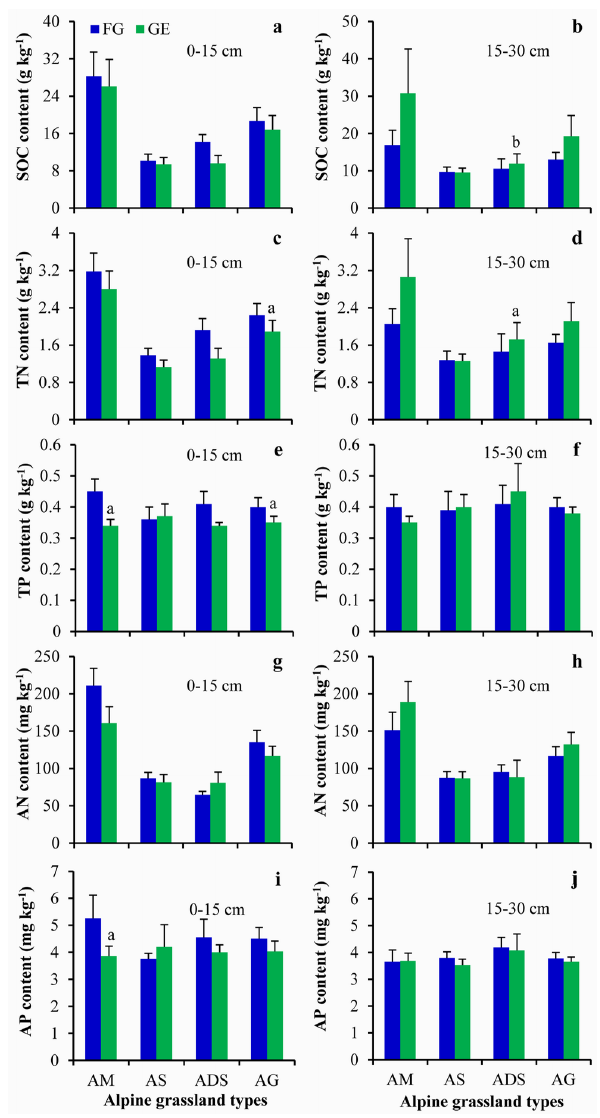
Figure 2. Statistical comparison of soil organic carbon (SOC), to- tal nitrogen (TN), total phosphorus (TP), available nitrogen (AN), and available phosphorus (AP) contents at 0–15 and 15–30cm depth using paired-difference t test ( α = 0 . 05) between free-grazing (FG) plots and grazing exclusion (GE) plots. Error bars repre- sent standard errors; AM, AS, ADS, and AG represent alpine meadow, alpine steppe, alpine desert steppe, and alpine grasslands (AM + AS + ADS), respectively. a: P < 0 . 05; b: P < 0 . 01.